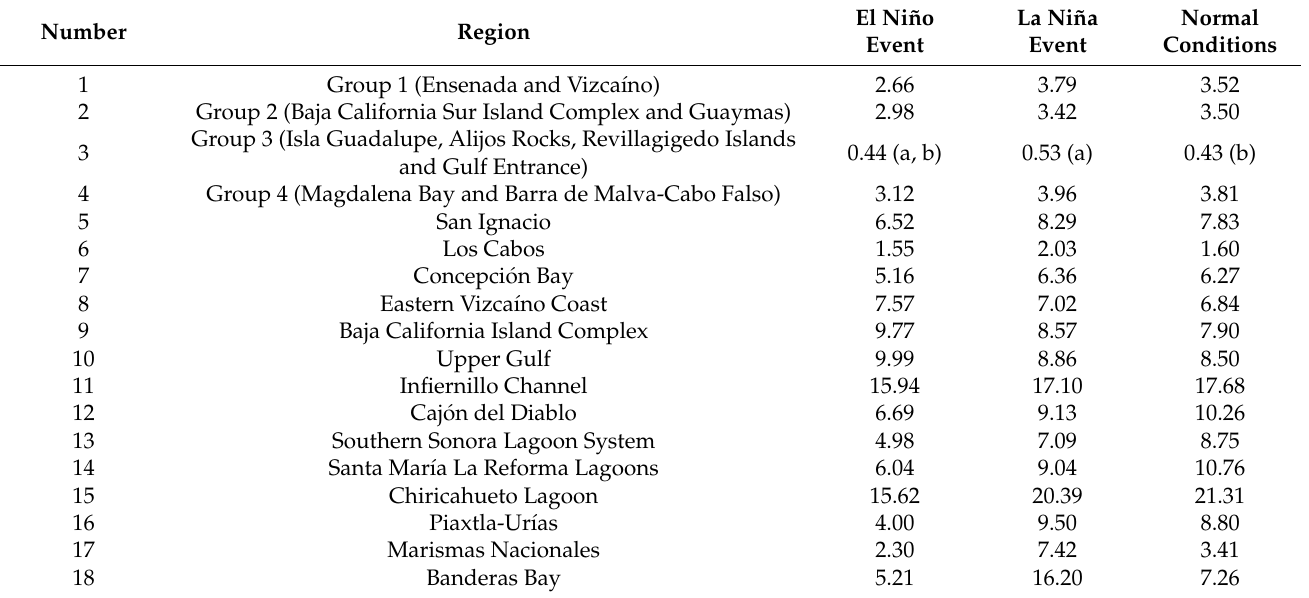
Table 2. Pairwise Permutation Test for the mean monthly spring chlorophyll a (Chl a ) values during El Niño and La Niña events, as well as in normal conditions, in the regions of the Northwest Pacific Ocean, Mexico. Columns sharing the same letter (for a fixed row) are not statistically different.